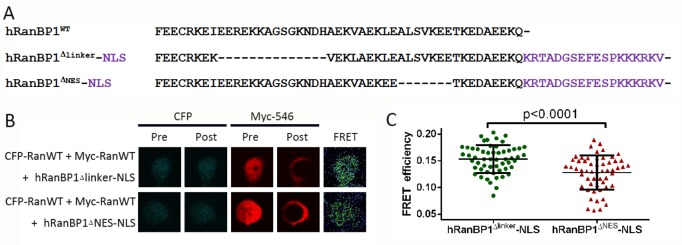
Acceptor photobleach-FRET and statistical analysis of FRET efficiencies.293 T cells were seeded in 24-well plates containing circular coverslips slides. After adhesion overnight, cells were transfected with Myc-Ran and CFP-Ran plasmids in addition to HA-tagged hRanBP1Δlinker-NLS or hRanBP1ΔNES-NLS (panel A, showing only the C terminus). Pull down experiments verified that RanBP1 tetramer formation is possible for hRanBP1Δlinker-NLS but not hRanBP1ΔNES-NLS. 24 hr after transformation, cells were fixed and stained with primary antibodies against Myc (ProteinTech, Mouse) and HA (CST, Rabbit) separately. The slides were then incubated with the secondary antibody anti-Mouse-Alexa Fluor 546 (ThermoFisher) and anti-Rabbit-Cy5 (ThermoFisher). FRET measurements were performed by acquiring pre- and post- acceptor bleach images of donor and acceptor using the Olympus FV-1000 acceptor photobleach FRET, followed by calculation of FRET efficiency for acquired images (B). Only cells transfected with two Ran plasmids and one RanBP1 plasmid were analyzed. Statistical significance (C) was calculated using two-tailed unpaired Student’s t test. Each group contains more than 40 cells.